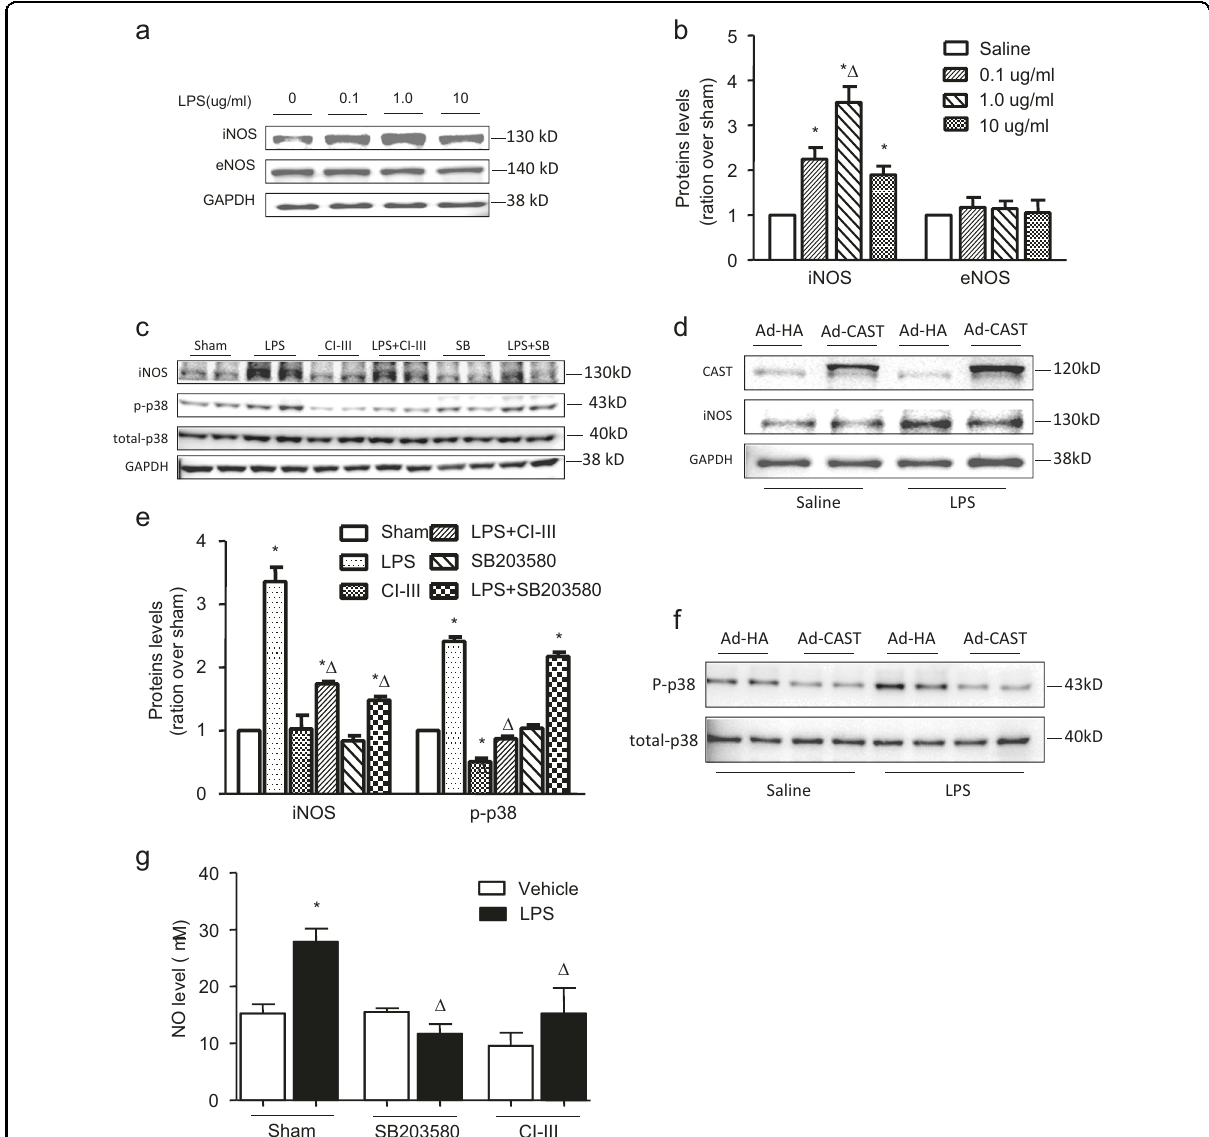
Fig. 5 Changes in iNOS expression and the role of calpains in p38 activation, LPS-induced iNOS expression and NO production in LPS- stimulated PMECs. PMECs were stimulated with different doses of LPS (0.1 – 10 µg/ml) for 18 h, and iNOS expression ( a ) was measured. b The corresponding bands on the western blot were quanti fi ed via densitometry (protein/GAPDH, presented as fold changes with respect to Sham). Then, PMECs were treated with calpain inhibitor III (CI-III, 5 µmol/l) or SB203580 (10 µmol/l) for 1 h and were then stimulated with LPS (1 µg/ml) for 18 h. c The expression levels of iNOS and total and phosphorylated p38 were measured by western blot analysis. d The corresponding bands were quanti fi ed via densitometry (p-p38/total p38 or iNOS/GAPDH, presented as fold changes with respect to Sham). PMECs were infected with calpastatin overexpression adenovirus (Ad-CAST) or control adenovirus (Ad-HA) for 24 h and were then stimulated with LPS (1 µg/ml) for 18 h. e The expression levels of calpastatin, iNOS and GAPDH were measured by western blot analysis. f The level of phosphorylated p38 was determined by western blot analysis. g NO production in the supernatant was measured. The data are presented as the means ± SD of 3 independent experiments. * P < 0.05 vs. the Sham vehicle group. Δ P < 0.05 vs. the LPS vehicle